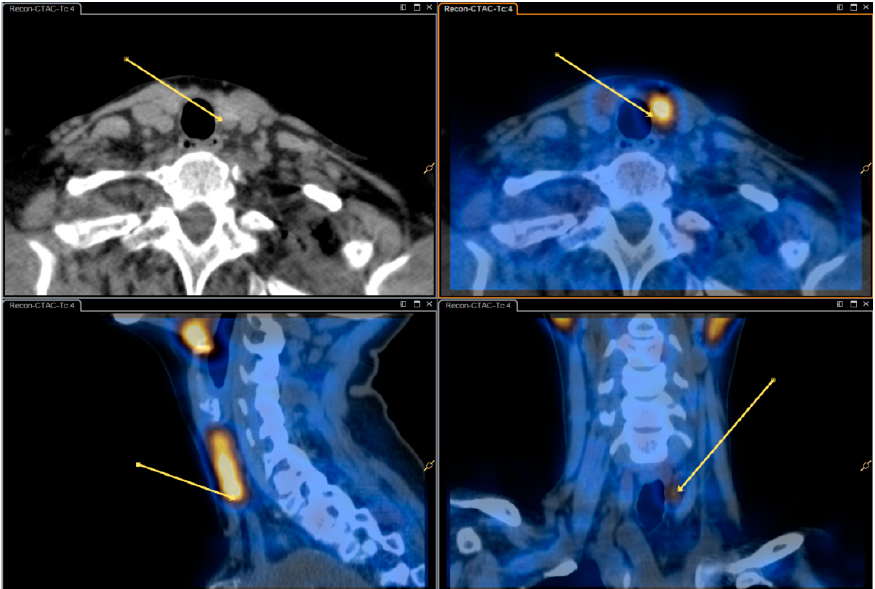
Figure 2. Single isotope SPECT / CT image (Tc-99m-sestamibi) with and without fusion—same patient as in Figure 1.